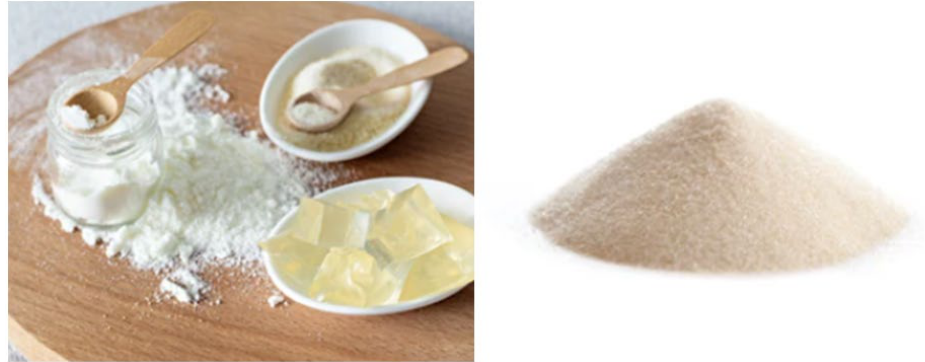
Figure 3. Commercially available gelatine powder for fabrication of SSE [45,46].